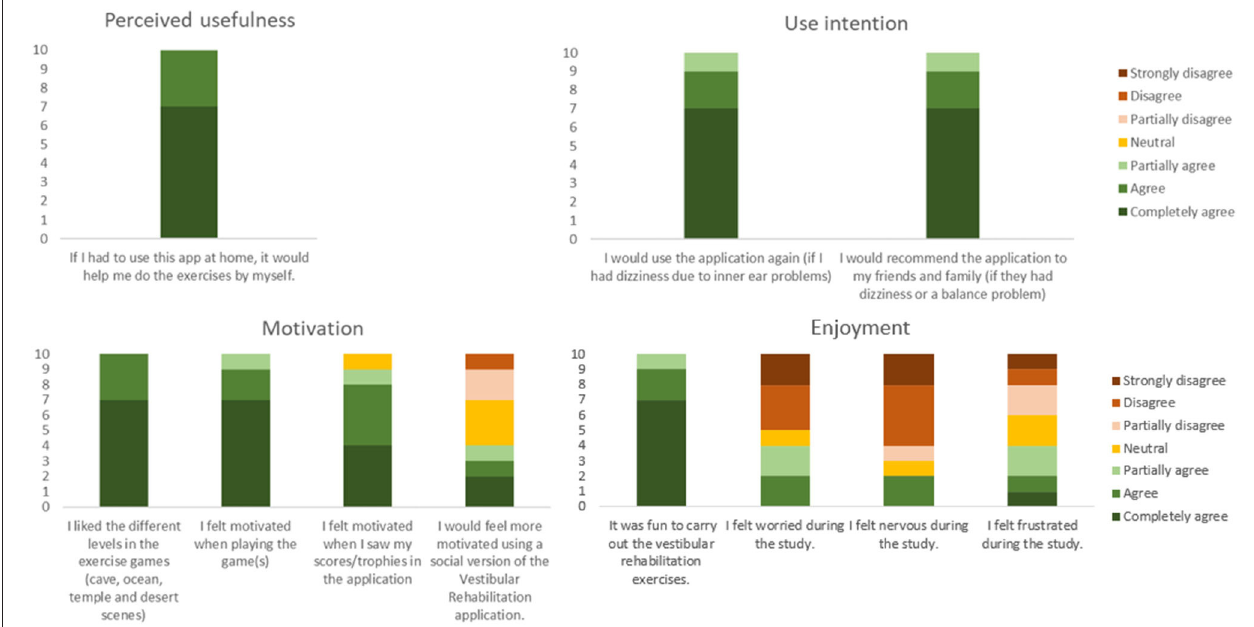
FIGURE 6 | Overview of responses to the usefulness, motivation, and enjoyment